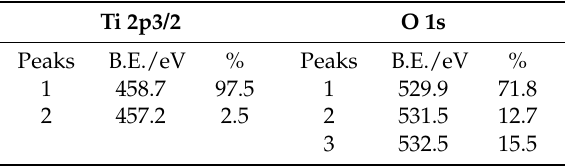
Table 1. Deconvolution of the Ti 2p and O 1s signals.